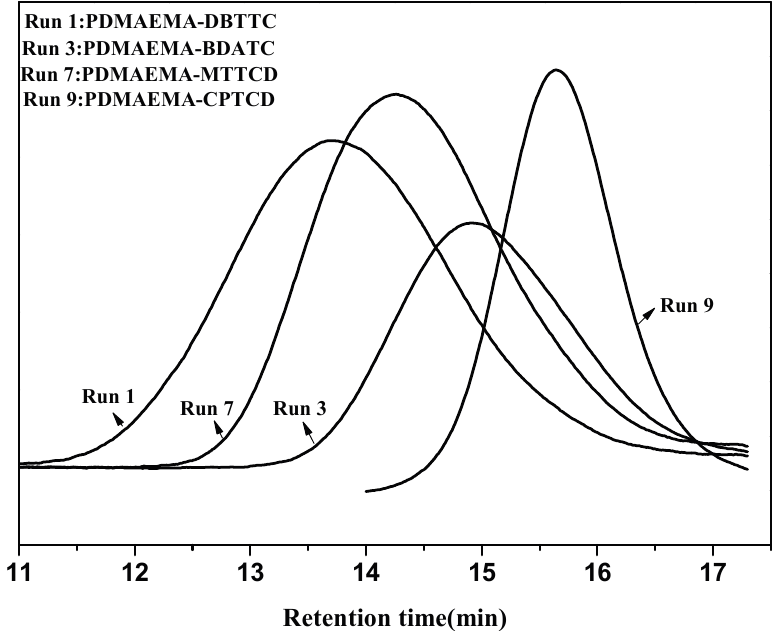
Figure 1. The gel permeation chromatograph (GPC) of poly ( N , N -dimethylaminoethyl methacrylate) (PDMAEMA) with different reversible addition-fragmentation chain transfer (RAFT) agents ( DMAEMA:DBTTC/BDATC/MTTCD/CPTCD:AIBN = 100:1:0.25, reaction time = 6